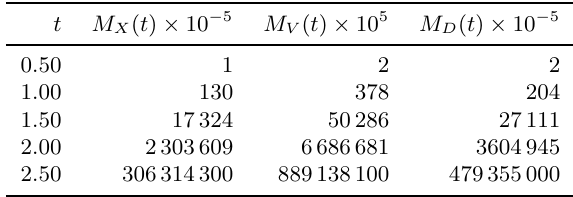
Table 3: M X ( t ) , M V ( t ) and M D ( t ) as a function of t (before treatment) with C = 3 , N = 412 ,